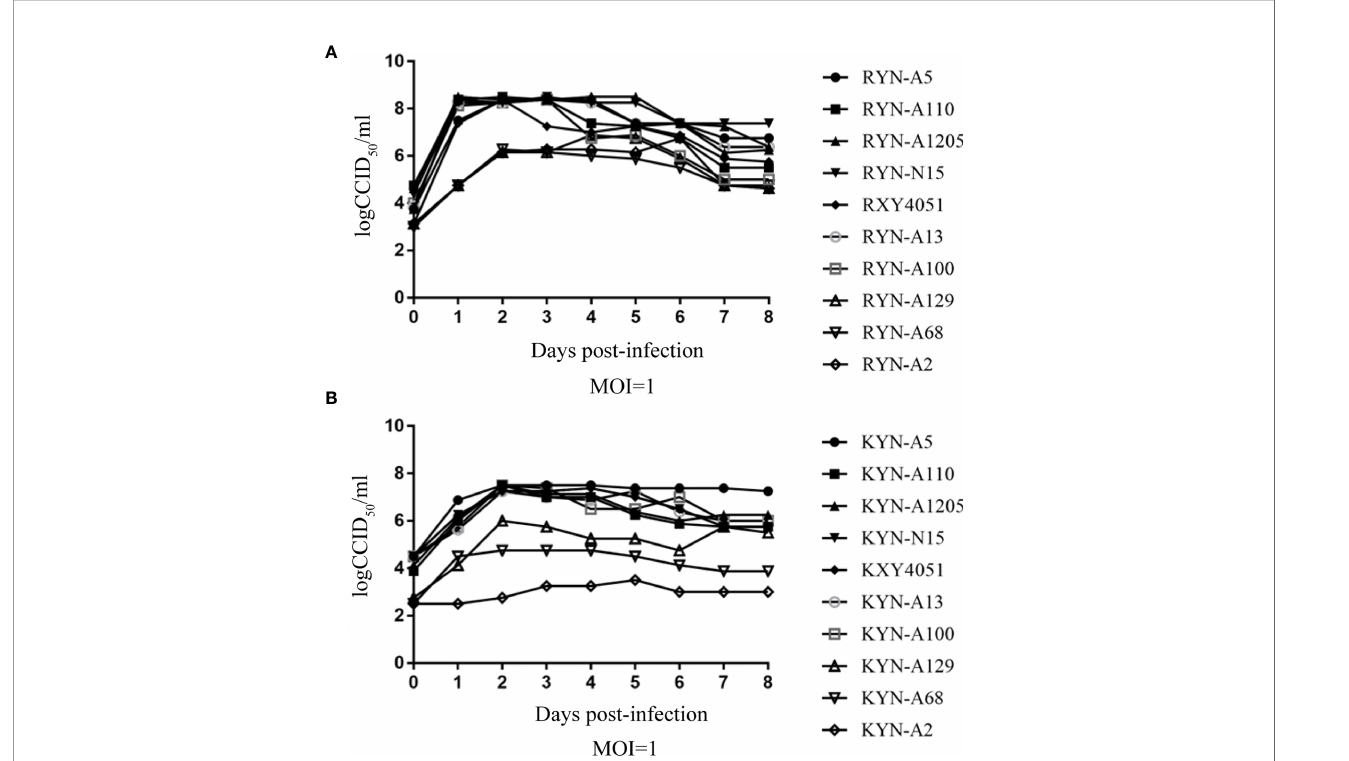
FIGURE 3 | The one-step growth curve of these high-titre RD cell-adapted strains and their KMB17 cell-adapted strains. Panel (A) (RD cell lines) and Panel (B) (KMB17 cell